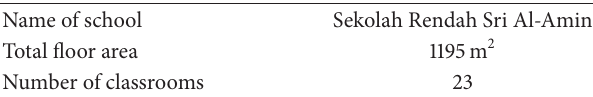
Table 3: Energy usage from electricity